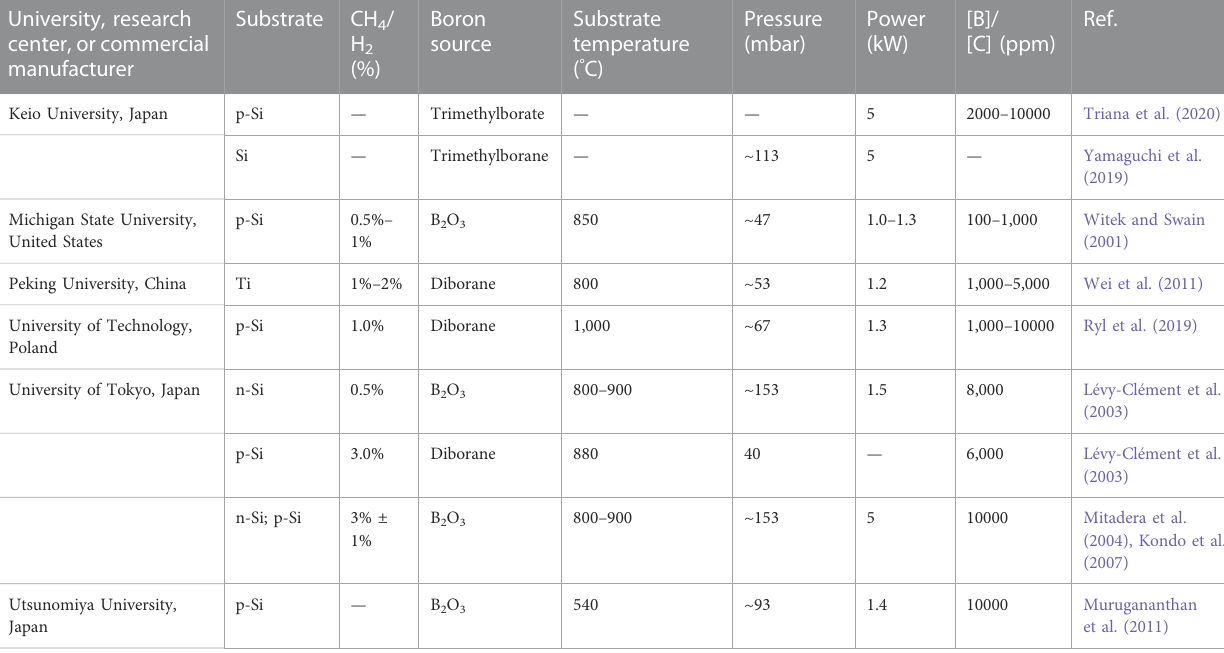
TABLE 2 MPCVD deposition conditions present in the literature based on the bibliometric analysis